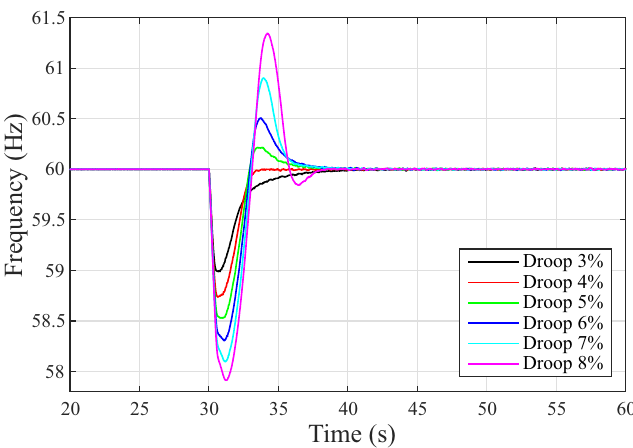
Figure 7. Frequency behavior with variation of the droop value for a wind speed of 10 m/s.